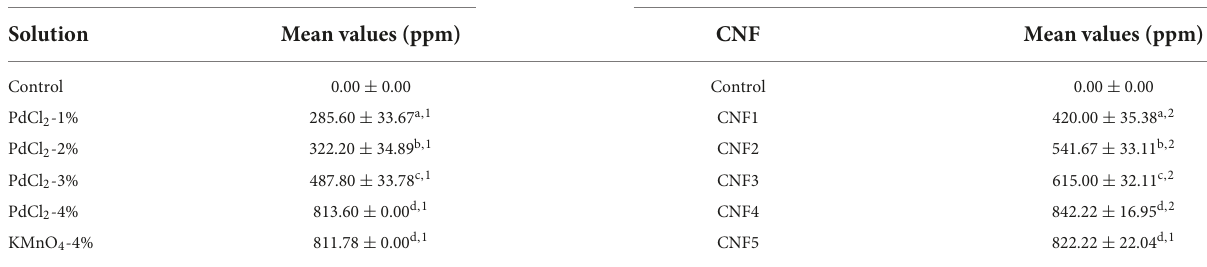
TABLE 2 Ethylene scavenging capacity of free and palladium (II) chloride encapsulated composite nanofibres. Free PdCl